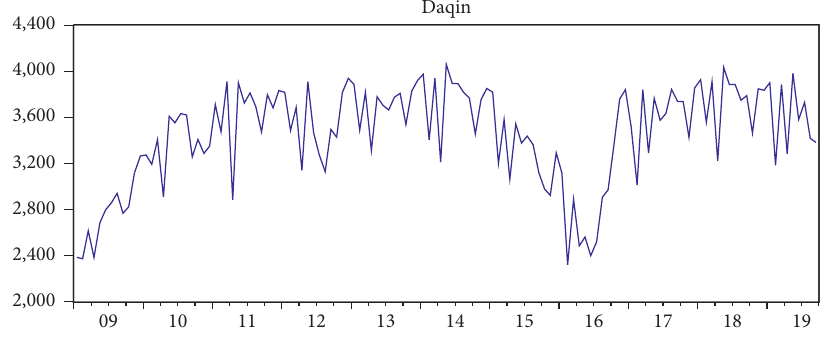
Figure 1: Time chart of the monthly coal traffic of Daqin